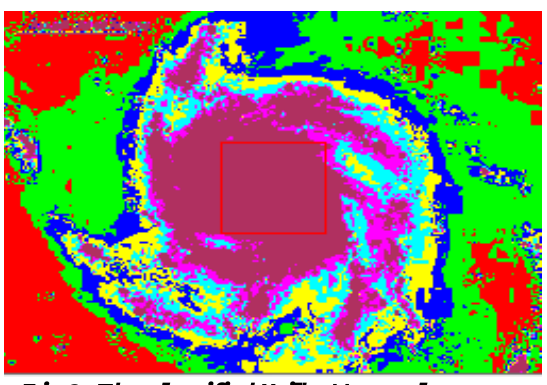
Fig.3: The classified Milky Way galaxy.